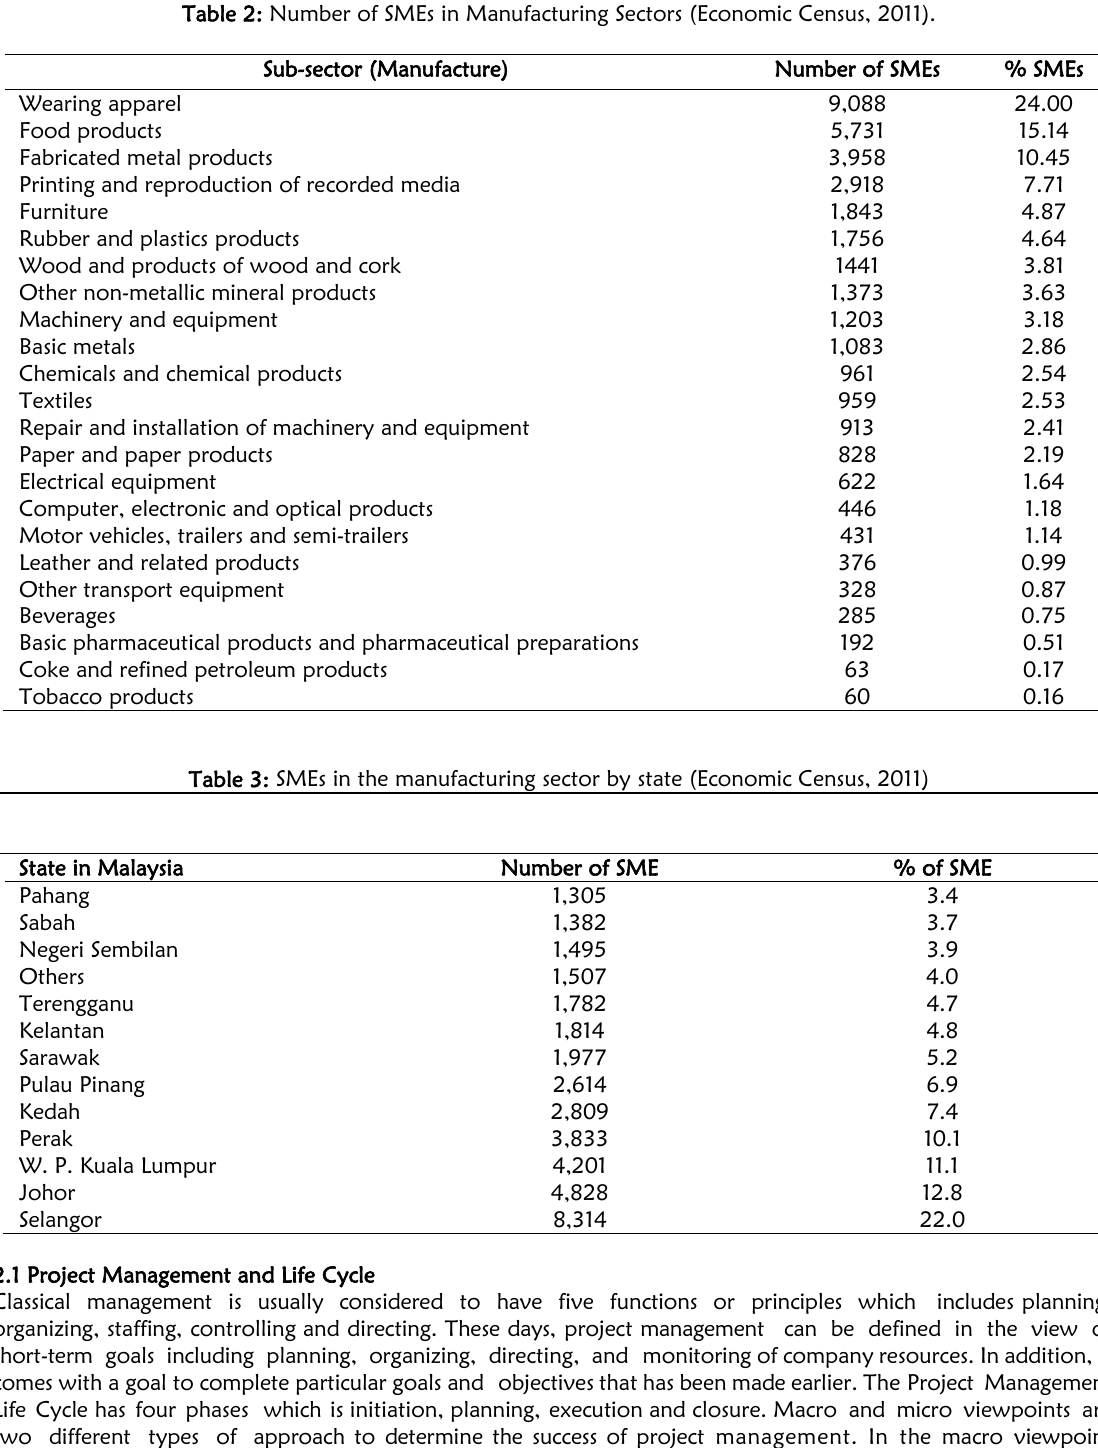
Table 2: Number of SMEs in Manufacturing Sectors (Economic Census, 2011).